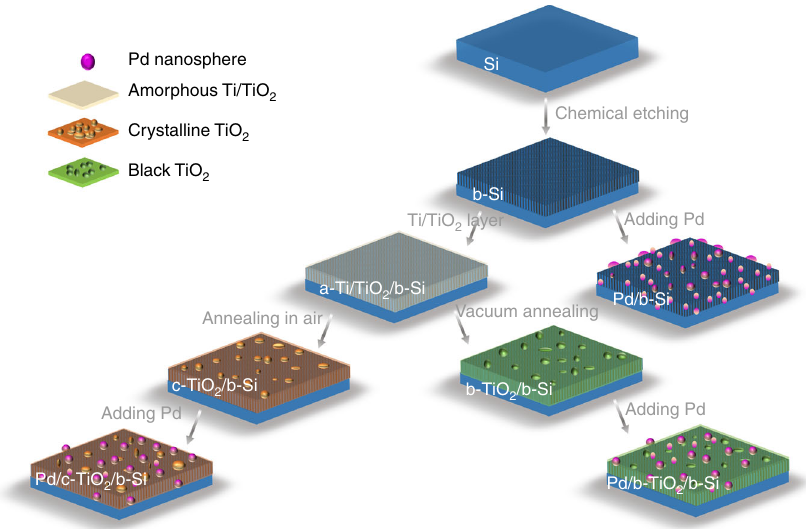
Fig. 1 Surface protecting strategies for b-Si